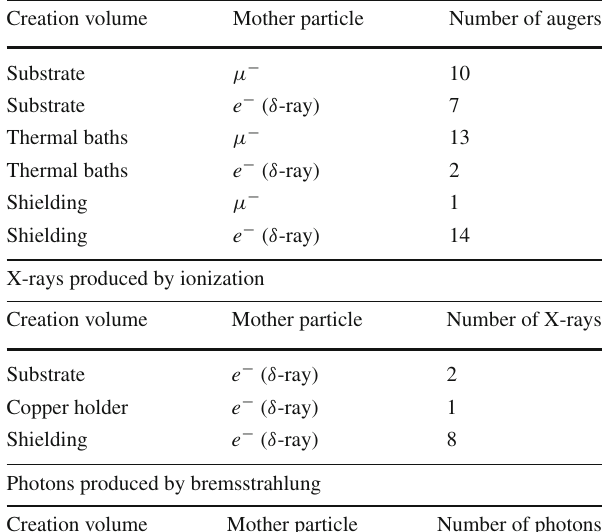
Nevertheless, the expected count rate of these events